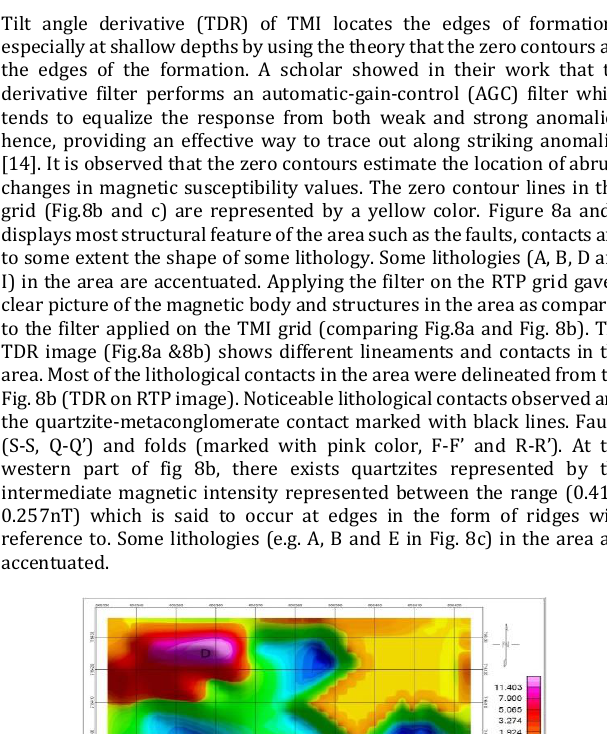
Figures 8 (a), (b) and (c) : Tilt angle derivative, TDR (a) TDR derived from RTP image (b) TDR derived from TMI (c) tilt derivative of location